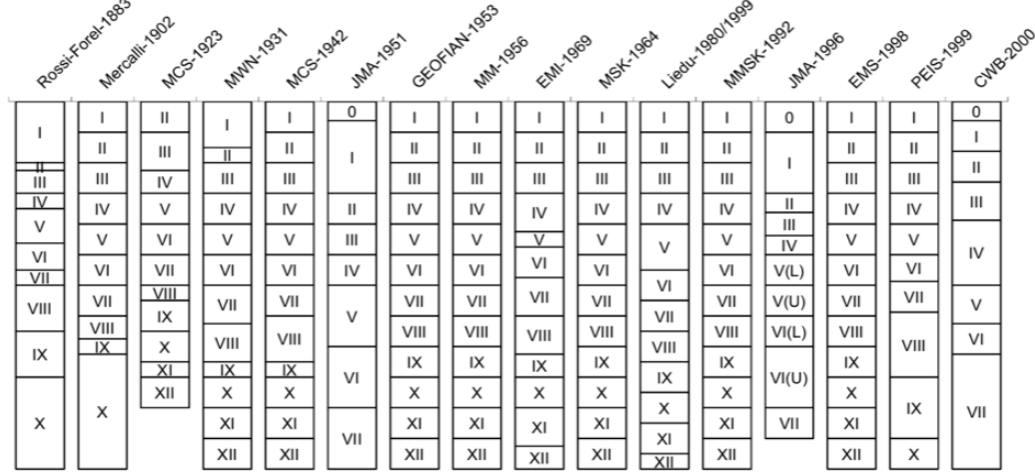
Figure A1. Comparison of the Chinese Seismic Intensity Scale with other internationally used seismic scales (Daniell, 2014; after the work of Gorshkov and Shenkareva, 1960; Barosh, 1969; Musson et al., 2010). In this figure, “Liedu-1980/1999” represents the Chinese Seismic Intensity Scale, which has marginal change compared with the current intensity scale GB/T 17742-2008 (2008) used in China.